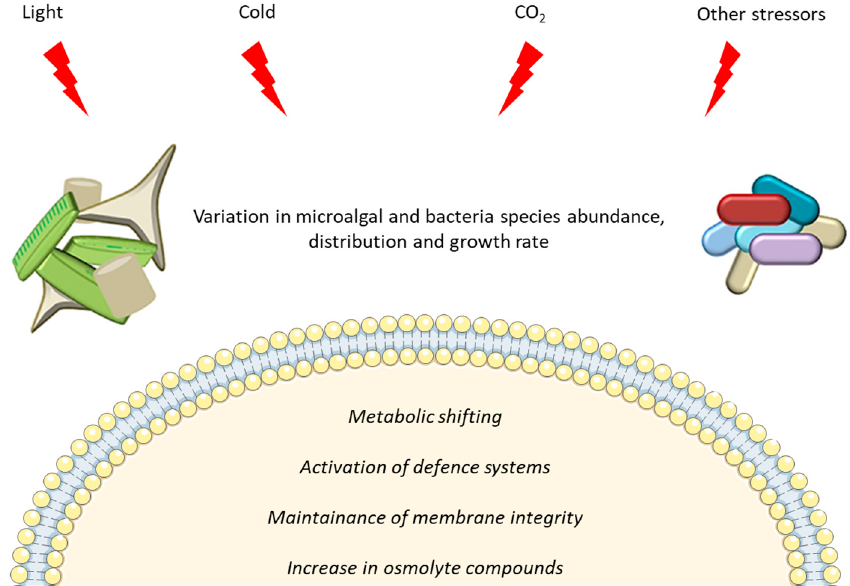
Figure 3. Representation of main effects induced in microalgae and bacteria by polar environmental stressors.